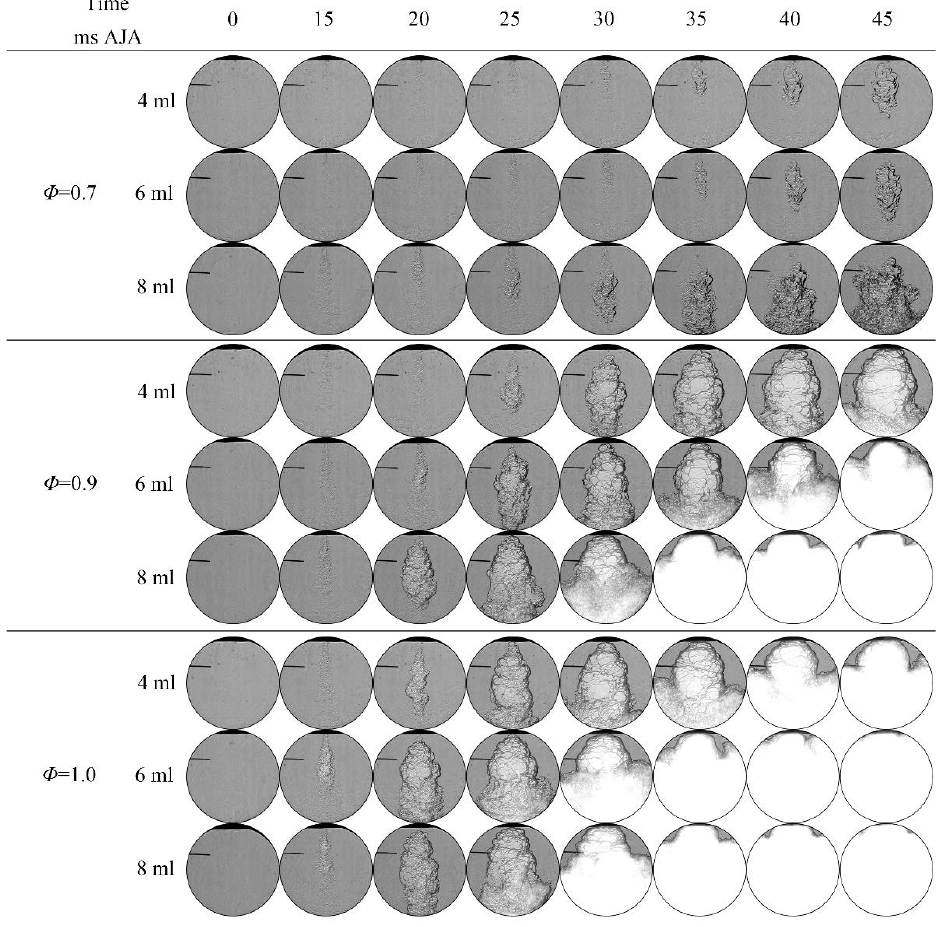
Figure 6. Shadow images of the jet ignition processes for different pre-chamber volumes at different equivalence ratios.